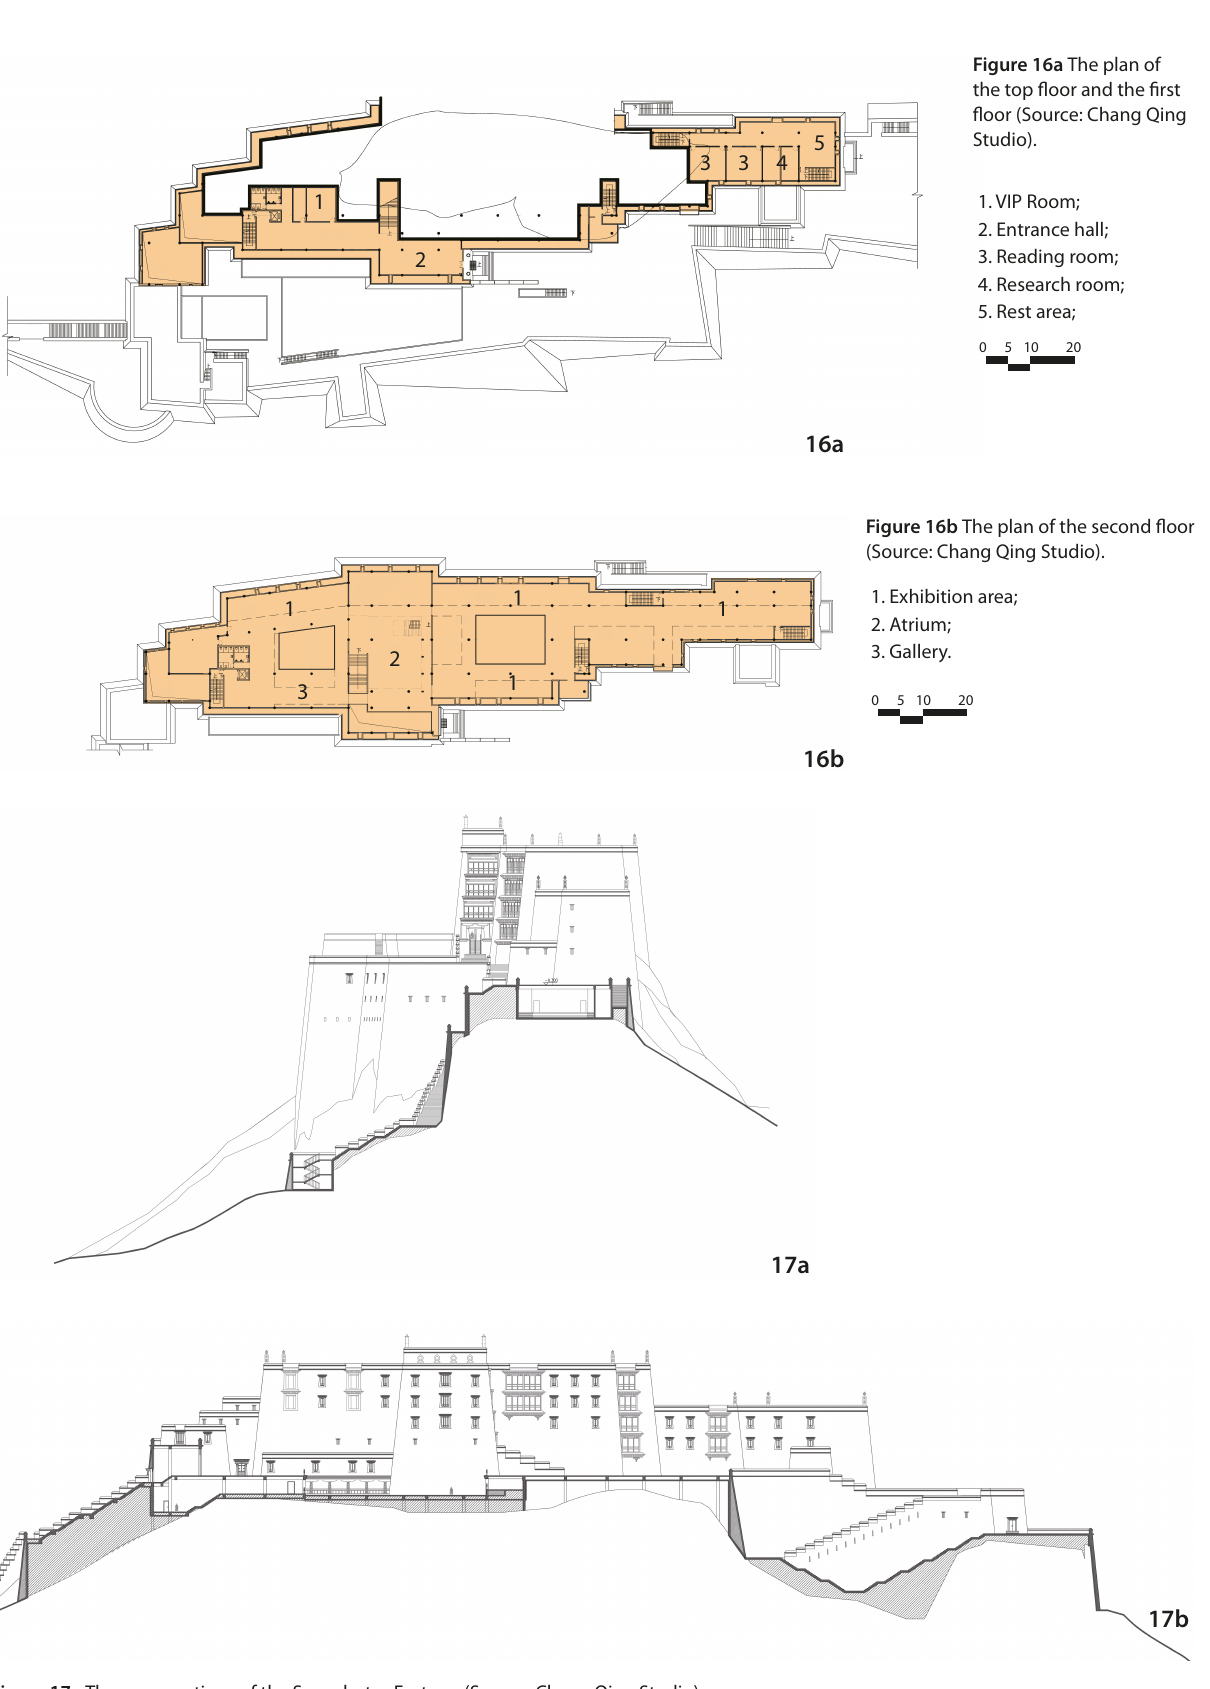
Figure 17a The cross sections of the Sangzhutse Fortress (Source: Chang Qing Studio). Figure 17b The longitudinal sections of the Sangzhutse Fortress (Source: Chang Qing Studio).